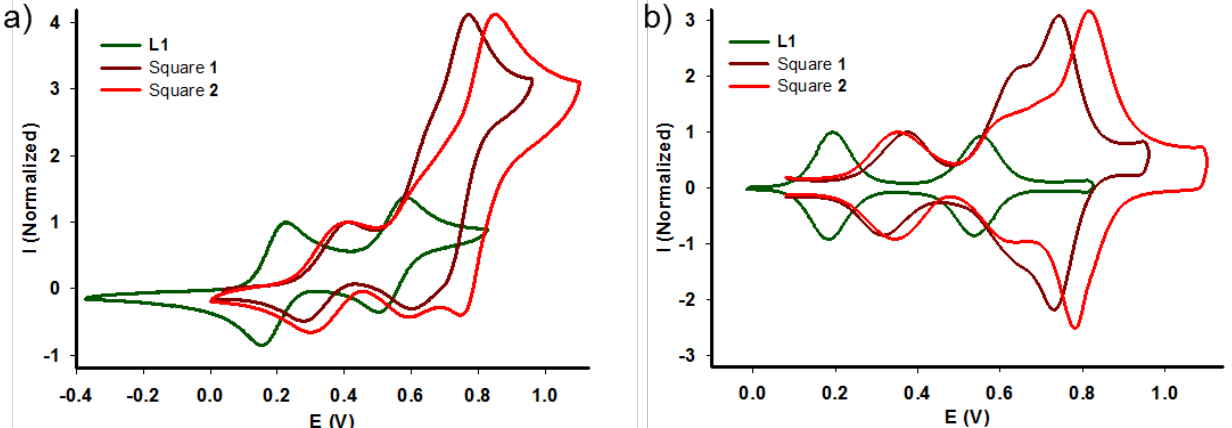
CN/CH Cl , 0.1 M n Bu NPF , 100 mV∙s −1 , Cgr) and of squares 1 and 3 2 2 4 6 CN, 0.1 M n Bu PF , 20 mV∙s −1 , Cgr), V vs Fc/Fc + 3 4 6